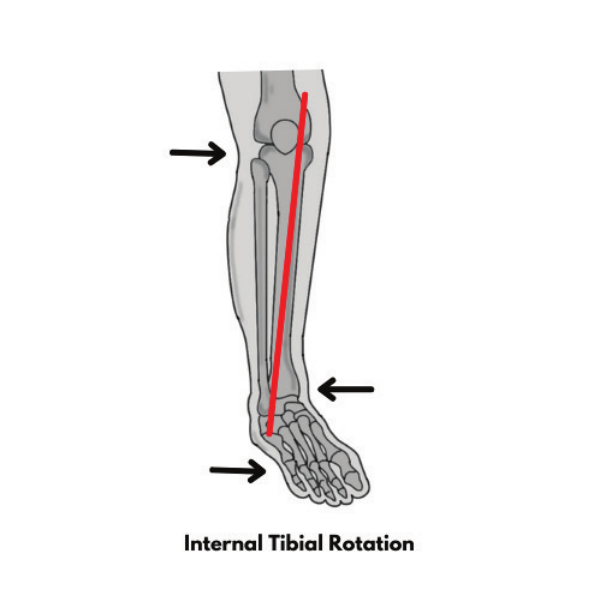
Figure-VI: Foot pronation causes the tibia to internally rotate, causing the knee ligamentous supports and the iliotibial band to stretch. Hips: The hips must adjust during pregnancy due to